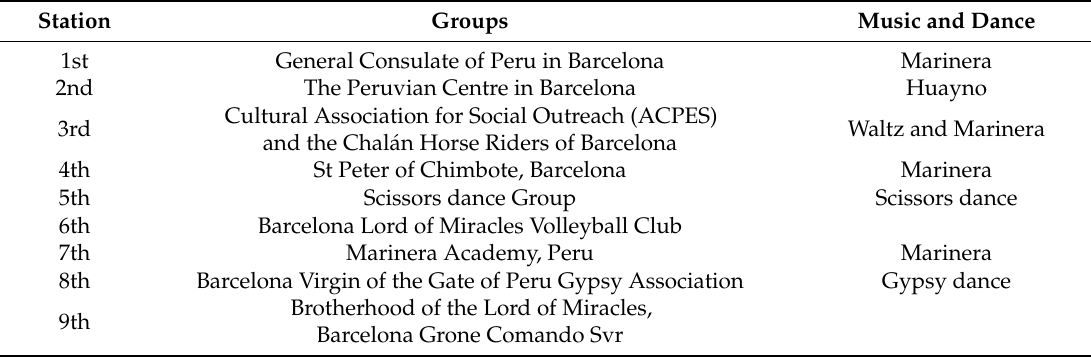
Table 2. Stations, groups, and cultural events in the 2016